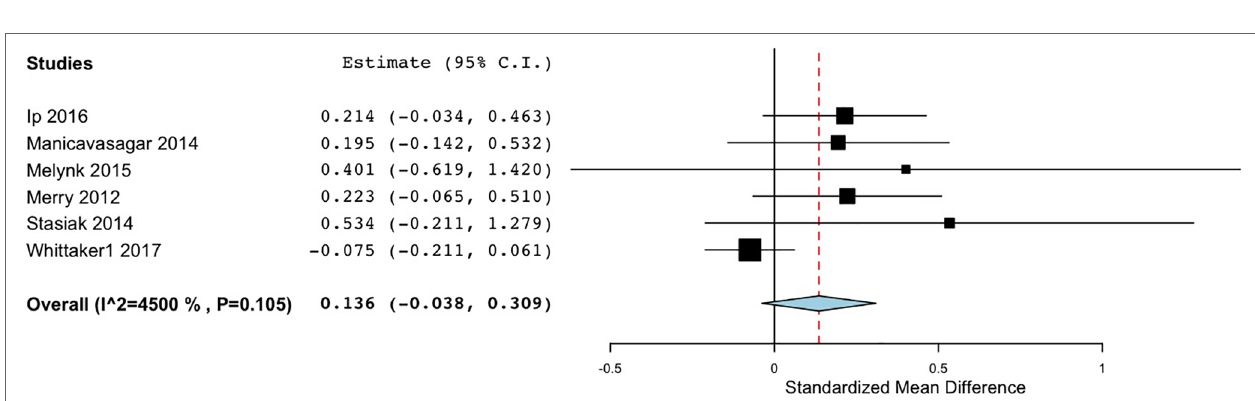
FIGURE 2 | Forest plot of meta-analysis of randomised controlled comparisons between DMHIs and no intervention for depression in adolescents.